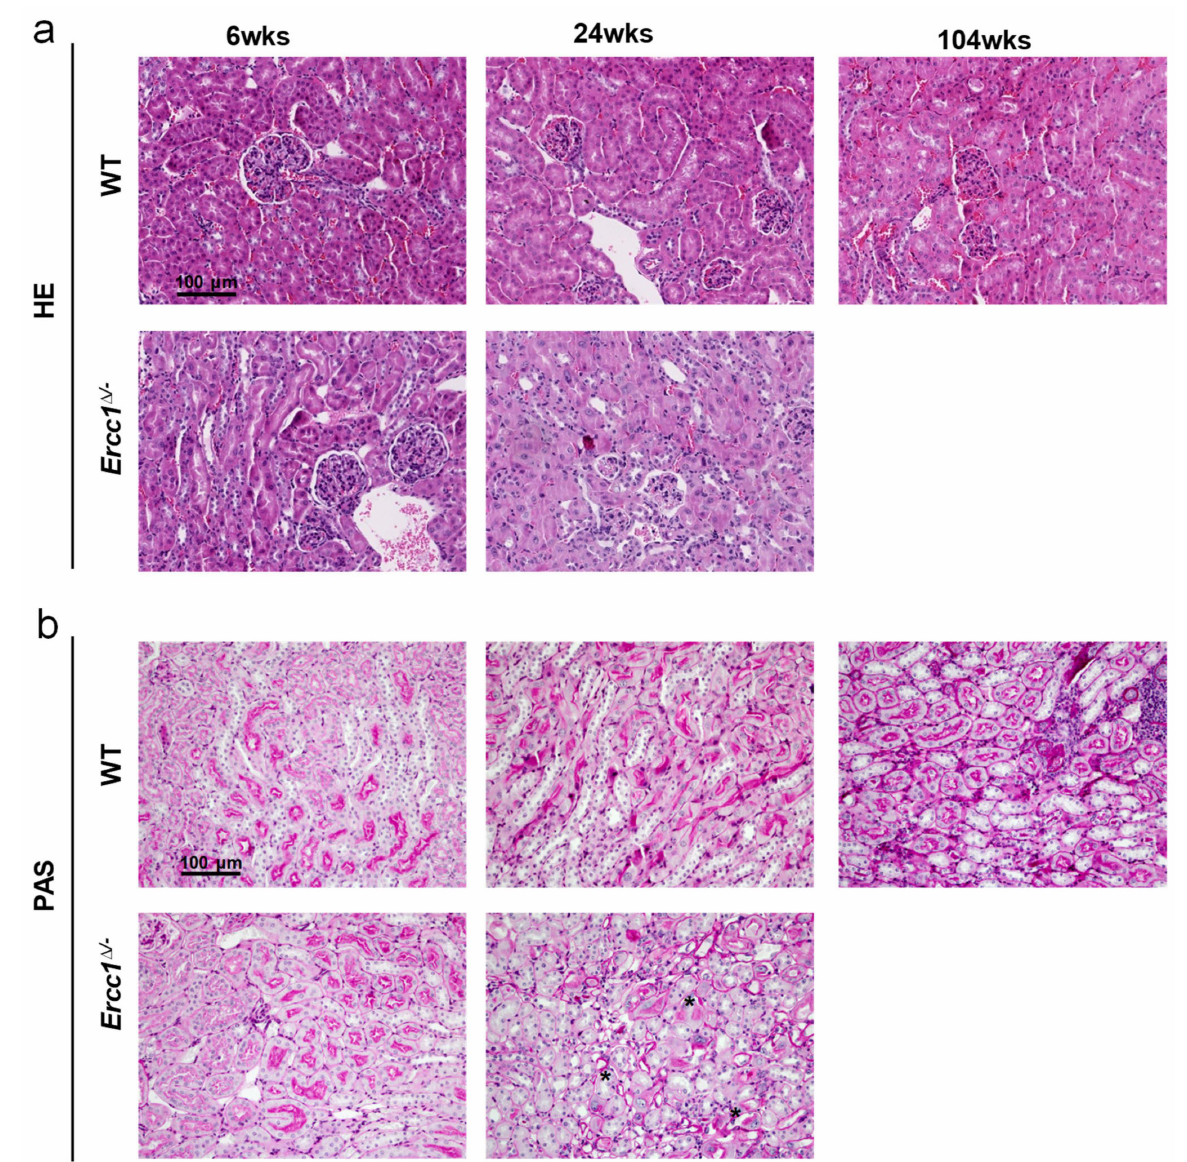
Figure 1. Histopathological changes in the kidneys of progeroid Ercc1 d / − mice. Representative pictures of hematoxylin and eosin (HE) ( a ), and periodic acid–Schiff (PAS) staining ( b ) of the kidneys of 6- and 24-week-old Ercc1 d / − mice, their wild-type (WT) littermates and old WT mice (104 weeks of age). Histological examination showed signs of kidney aging, including anisokaryosis, tubular degeneration, loss of brush borders and glomerulosclerosis in kidneys of Ercc1 d / − mice at 24 weeks of age (indicated by * in the PAS staining). In all panels, scale bar = 100 µ